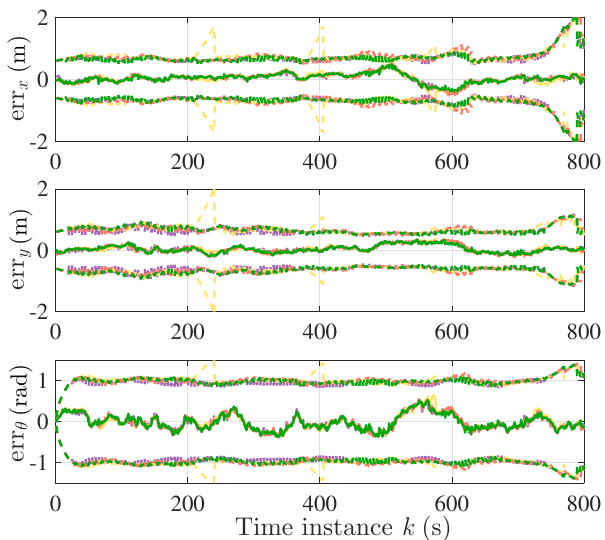
Figure 6. Target tracking errors and covariance of robots 1–4.